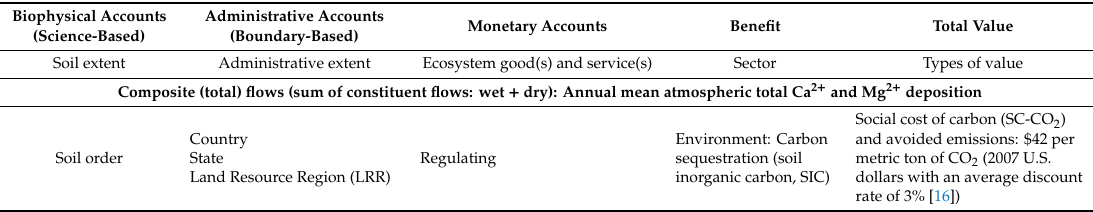
Table 3. Conceptual overview of the accounting framework for a systems-based approach in the ecosystem services valuation of various atmospheric magnesium deposition flows used in this study (adapted from Groshans et al., 2018